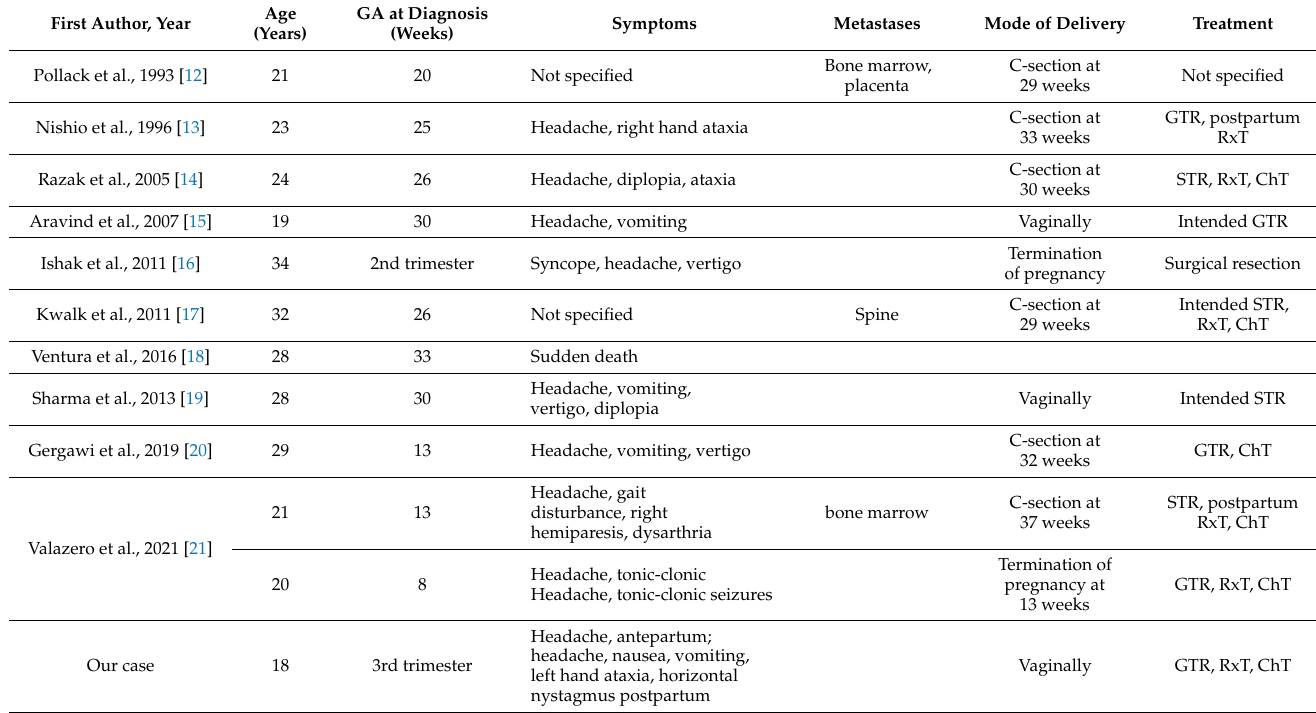
Table 2. Cases of MB in pregnant patients published in the literature. C-section: caesarean section; GTR: gross total removal; STR: subtotal removal; RxT: radiotherapy; ChT: